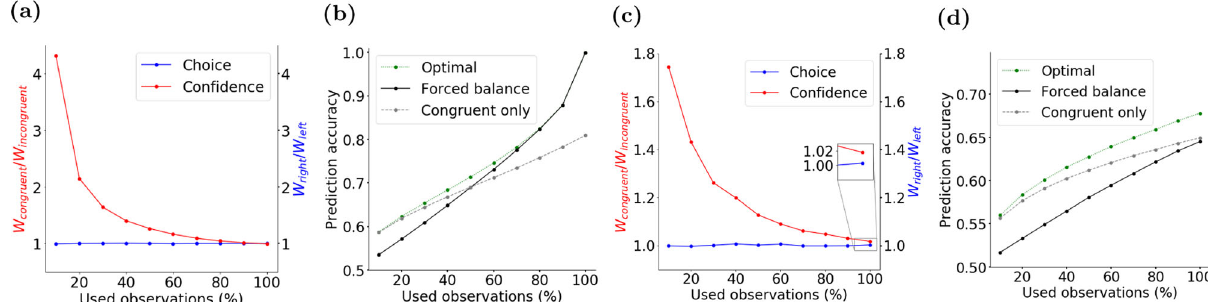
Fig. 7 POMDP model explains seemingly higher in fl uence of choice-congruent evidence on con fi dence ratings. Discrepancy in the observations used by a decision maker and those used by an experimenter studying the decision maker ’ s behavior could lead to biased interpretation of experimental results. a We simulated a POMDP model that uses a fraction of observations available in a trial unbeknownst to the experimenter. The observations supporting opposing choices equally inform the model ’ s behavior. However, an experimenter who uses a classi fi er to predict choices and con fi dence based on all observations in the trial fi nds an apparently larger in fl uence of choice-congruent observations on con fi dence. b Forcing the classi fi er to have balanced weights for all observations causes lower prediction accuracy of con fi dence ratings, especially when the proportion of used evidence is low. In such cases, even a model that totally ignores choice-incongruent observations performs better than the balanced model. However, the better performance of models with imbalanced weights does not re fl ect the decision making process. It stems merely from the experimenter ’ s lack of knowledge about the observations used by the simulated model. c , d Same as ( a , b ) but observations accessible to the experimenter are noisy estimates of observations available to the decision maker. Such noise reduces the prediction accuracy of the experimenter ’ s classi fi er, but more importantly, it also causes imbalanced weights in the optimal classi fi er ( c ) and lower performance of the balanced classi fi er ( d ). That is true even when both the decision maker and experimenter use all the available observations (see inset box in ( c )). The noise in these simulations comes from a zero-mean Gaussian distribution with a variance 25% larger than w 2 z